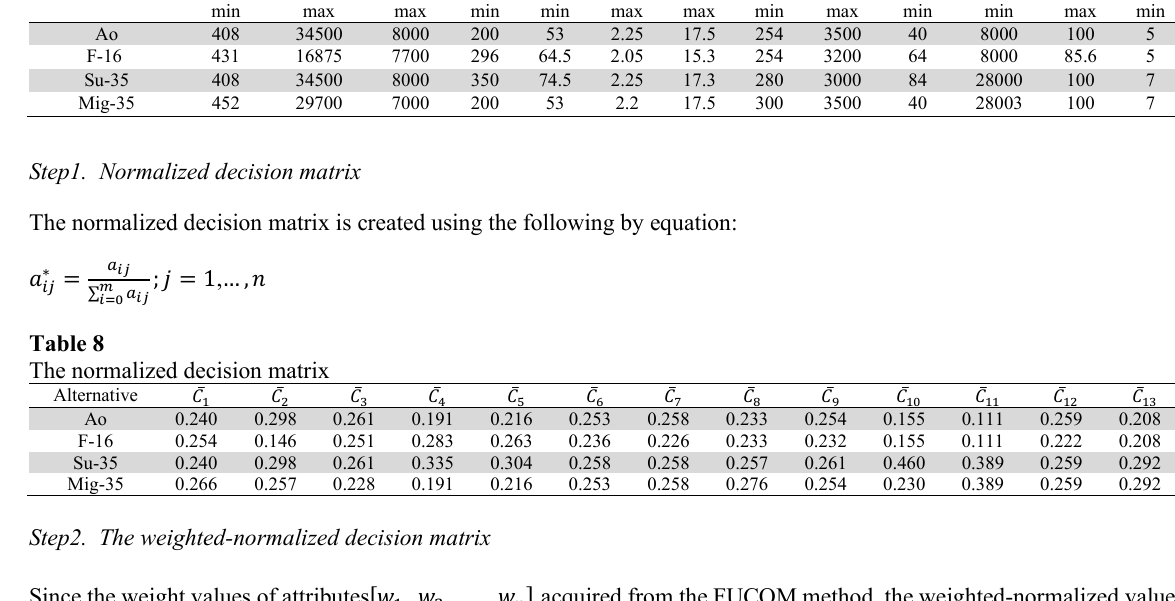
Initial decision making matrix Alternative